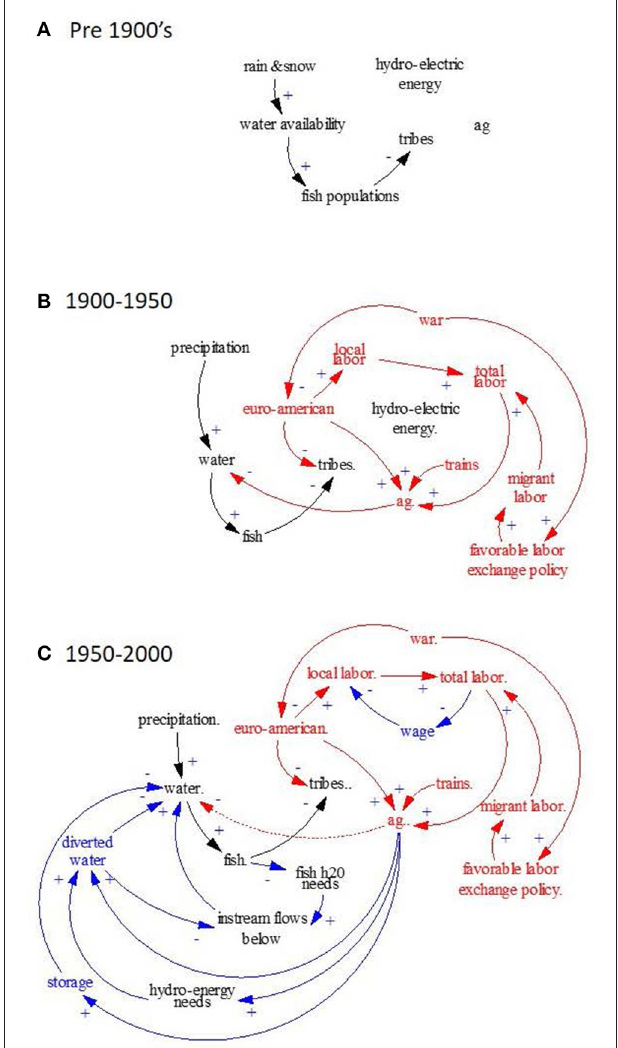
FIGURE 3 | Development of linkages and feedbacks in the Yakima River Basin. (A) Pre 1990, (B) 1900-1950, and (C)